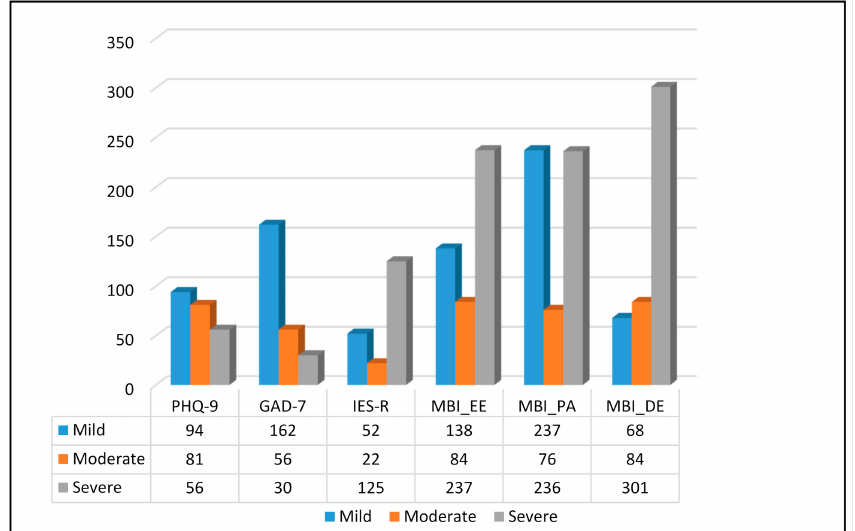
Figure 3. Number of participants with mild, moderate and severe symptoms of depression, anxiety, stress and burnout. PHQ-9 = Patient Health Questionnaire-9; GAD-7 = General Anxiety Disorder-7; IES-R = Impact of Event Scale-Revised; MBI_EE = Maslach Burnout Inventory, Emotional Exhaustion; MBI_PA = Maslach Burnout Inventory, Personal Accomplishment; MBI_DE = Maslach Burnout Inventory,